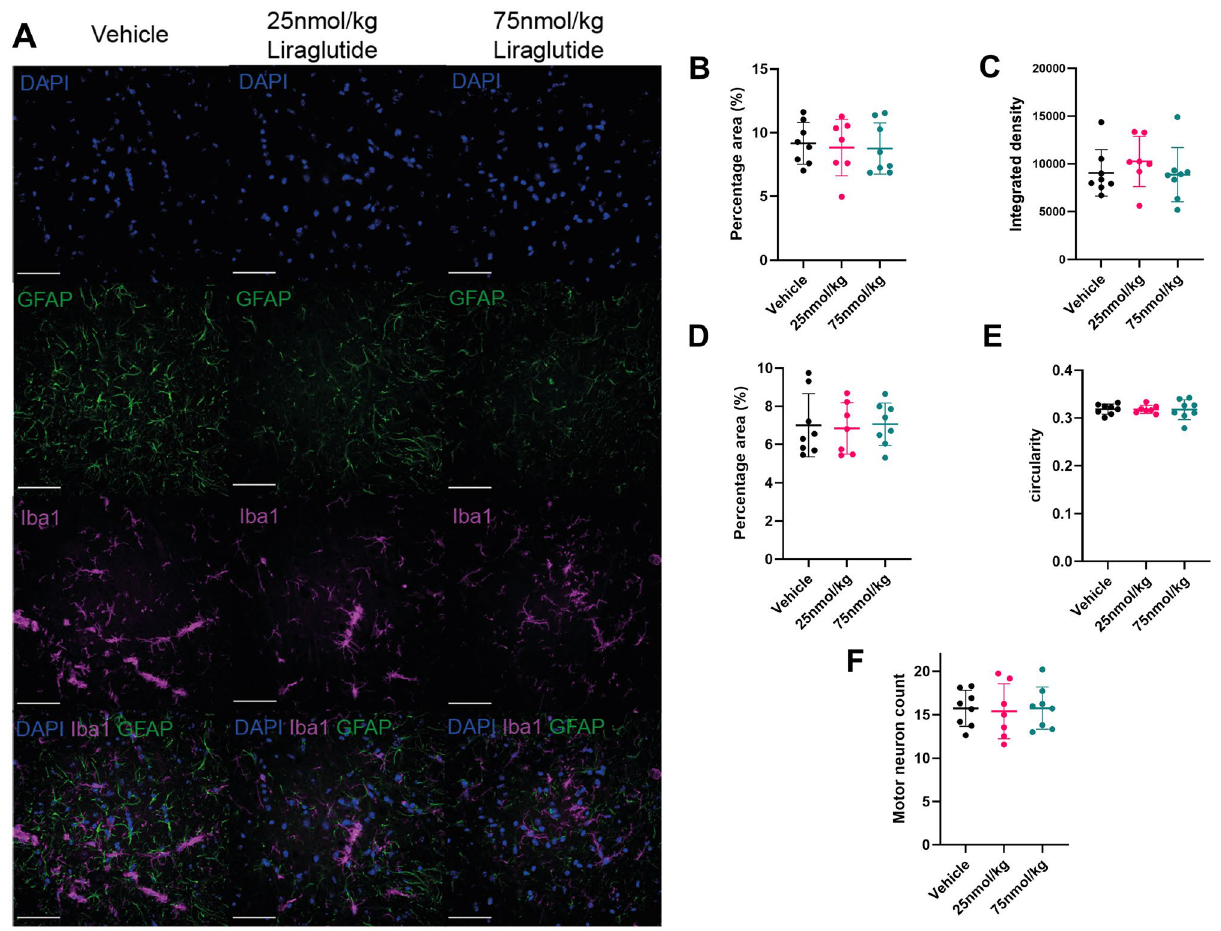
Figure 4. GFAP, Iba1 and Nissl staining of SOD1 G93A lumbar spinal cord shows no difference between liraglutide and vehicle dosed animals in a SOD1 G93A mouse model. All fluorescence images were captured on the INCELL 2000 (GE) at 60 × magnification. ( A ) Representative images of DAPI, Iba1 and GFAP staining of ventral horns from lumbar spinal cord sections from vehicle, 25 nmol/kg and 75 nmol/kg liraglutide dosed SOD1 G93A mice at 90 days of age. Scale bar is 50 μm. ( B ) Quantification of percentage area coverage of GFAP staining plotted as individual values with mean ± SD shows no significant difference between vehicle and liraglutide dosed mice (n = 7 or 8 per group, one-way ANOVA, P = 0.7824). ( C ) Integrated density of GFAP staining plotted as individual values with mean ± SD shows no significant difference between liraglutide and vehicle dosed groups (n = 7 or 8 per group, one-way ANOVA, P = 0.9754). ( D ) Iba1 percentage area coverage plotted as mean ± SD shows no significant difference between liraglutide and vehicle dosed mice (n = 7 or 8 per group, one-way ANOVA, P = 0.7107) ( E ) Circularity of Iba1 staining shown as individual values with mean ± SD shows no significant difference between liraglutide and vehicle dosed animals (n = 7 or 9 per group, one-way ANOVA, P = 0.9927). ( F ) Motor neuron counts from Nissl stained lumbar spinal cord sections shown as individual values with mean ± SD shows no significant difference between liraglutide and vehicle dosed animals (n = 7 or 8 per group, one-way ANOVA, P =